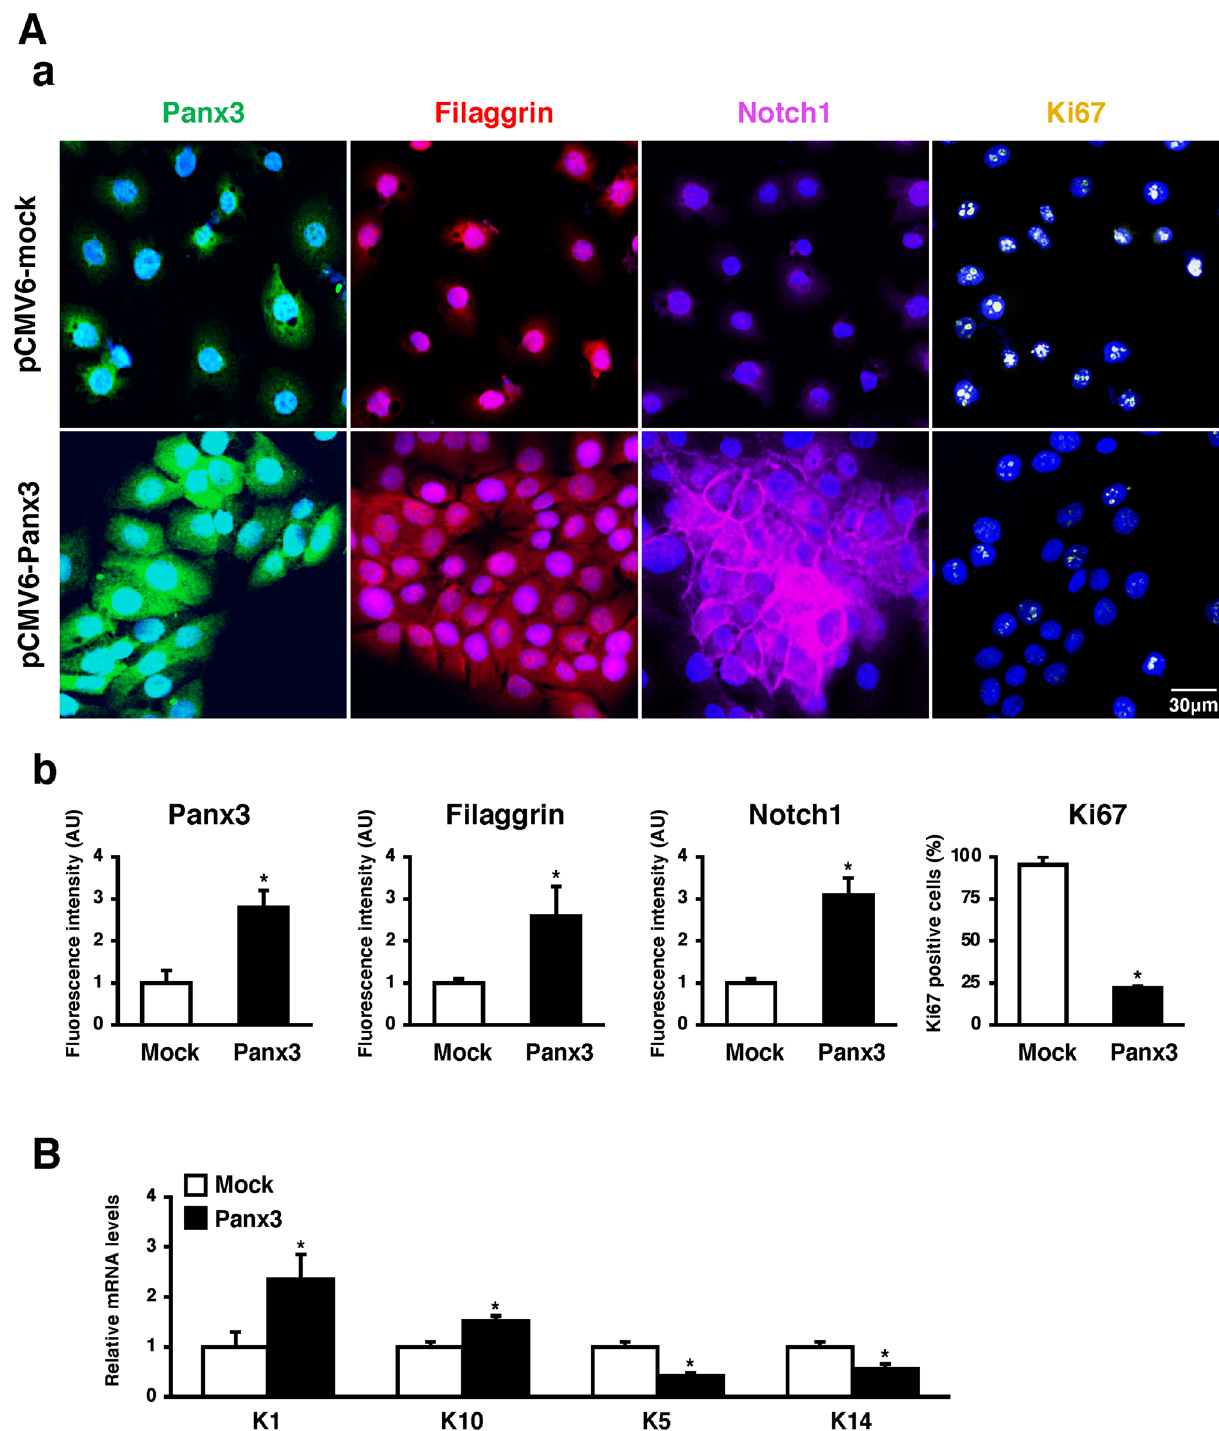
Figure 3. Panx3 regulates HaCaT cell differentiation. ( A ) Immunostaining of Panx3 (green), Filaggrin (red), and Notch1 (purple), Ki67 (yellow) in pCMV6-mock or pCMV6-Panx3 transfected HaCaT cells cultured in normal condition media ( a ). Relative fluorescence intensity comparison of images and % of Ki67 positive cells were analyzed ( b ). * p < 0.01. Error bars represent the mean ± SD; N = 3. The nuclei were counterstained with DAPI (blue in merged). ( B ) qPCR for K1, K10, K5, and K14 in pCMV6-mock or pCMV6-Panx3 transfected HaCaT cells. Results represent the mean ± SD; N = 3. * p <